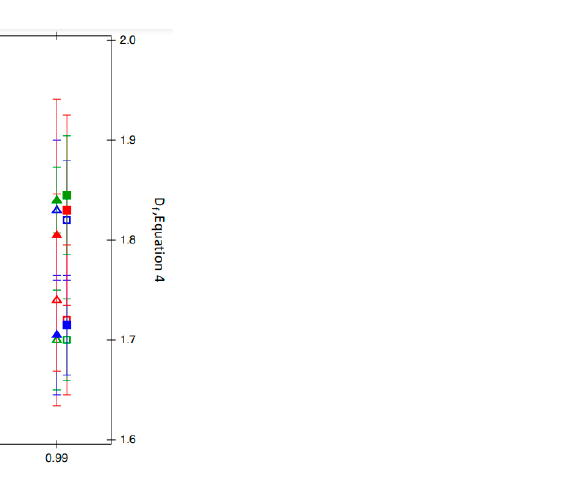
Figure 5. Plot of 3D fractal dimensions derived from Equations (3) and (4) as a function of MCE. The MCE values for BGM fractal dimensions were offset by 0.001 to allow for better viewing. Note the different scales for each equation.